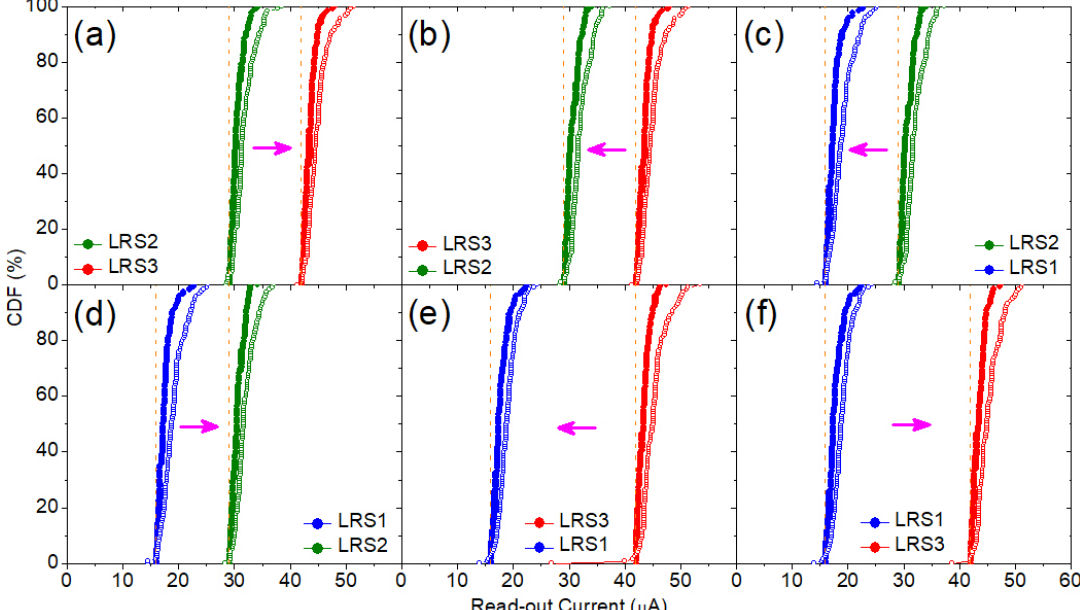
Figure 4. CDFs of the experimentally measured read-out currents measured just after the switching operation (solid symbols) and at the end of the M-ISPVA (open symbols) of the three LRS conductive levels before and after the six LRS-LRS possible transitions: LRS2 → LRS3 ( a ), LRS3 → LRS2 ( b ), LRS2 → LRS1 ( c ), LRS1 → LRS2 ( d ), LRS3 → LRS1 ( e ), and LRS1 → LRS3 ( f ).